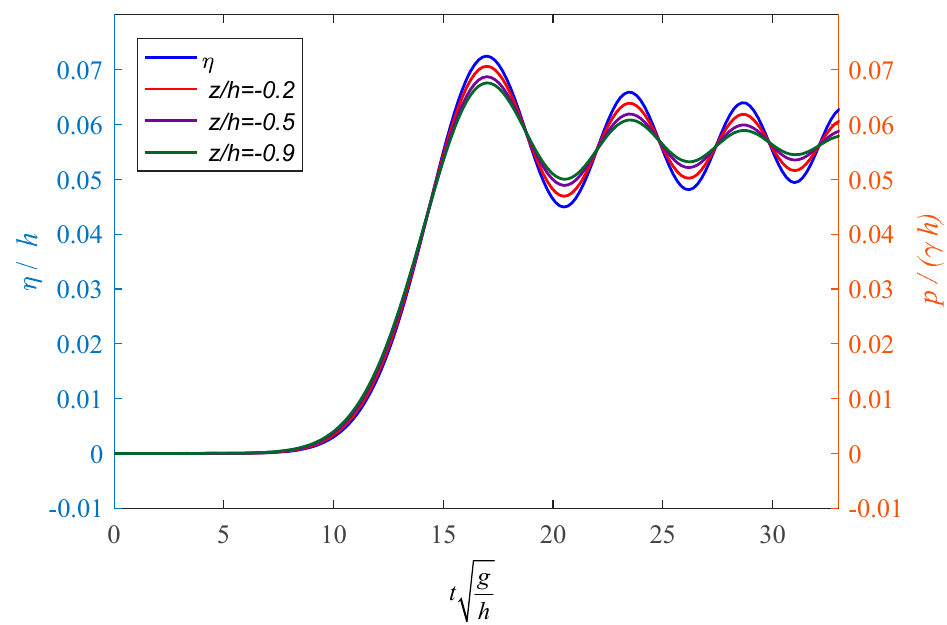
Figure 8. Variation of pressure at different water depths.